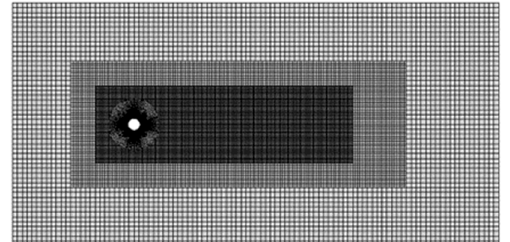
Figure 2. Schematic diagram of the computational mesh for the validation.